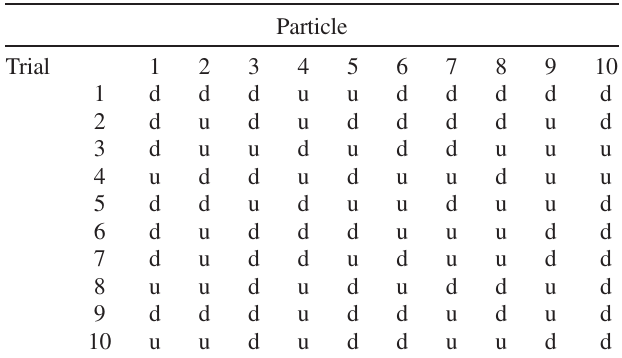
TABLE I. Consecutive height bifurcation trials of 10 randomly chosen sulfated polystyrene particles in 1 mM NaOH with a 5 Vpp, 100 Hz applied potential. The rows correspond to each trial while the columns correspond to each specific individual particle; the same individual particles are tracked through all 10 trials. A “ d ” indicates a particle that moves down, and a “ u ” indicates a particle that moves up [cf. Figs. 1(b) and 2(b)].